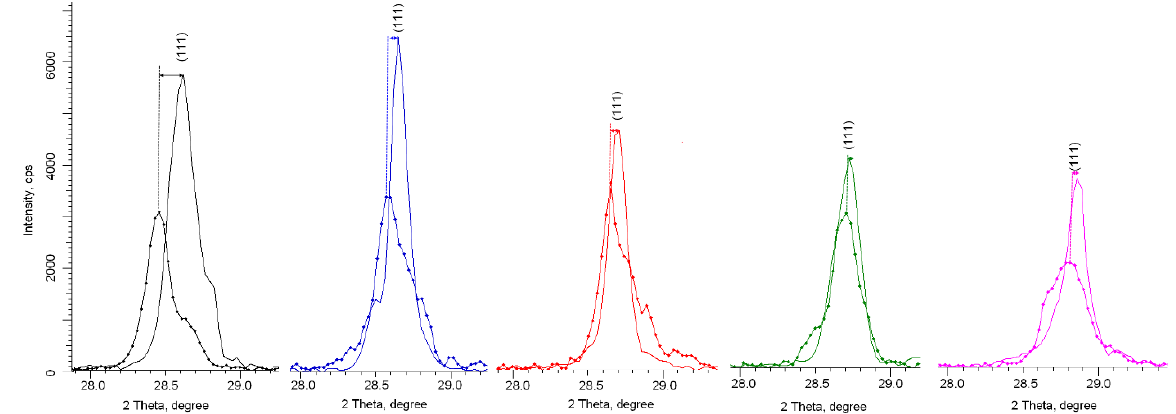
Figure 6. Dynamics of changes in the shape and position of the main diffraction reflex (111) for samples in the pristine (solid line) and irradiated state (dashed line).